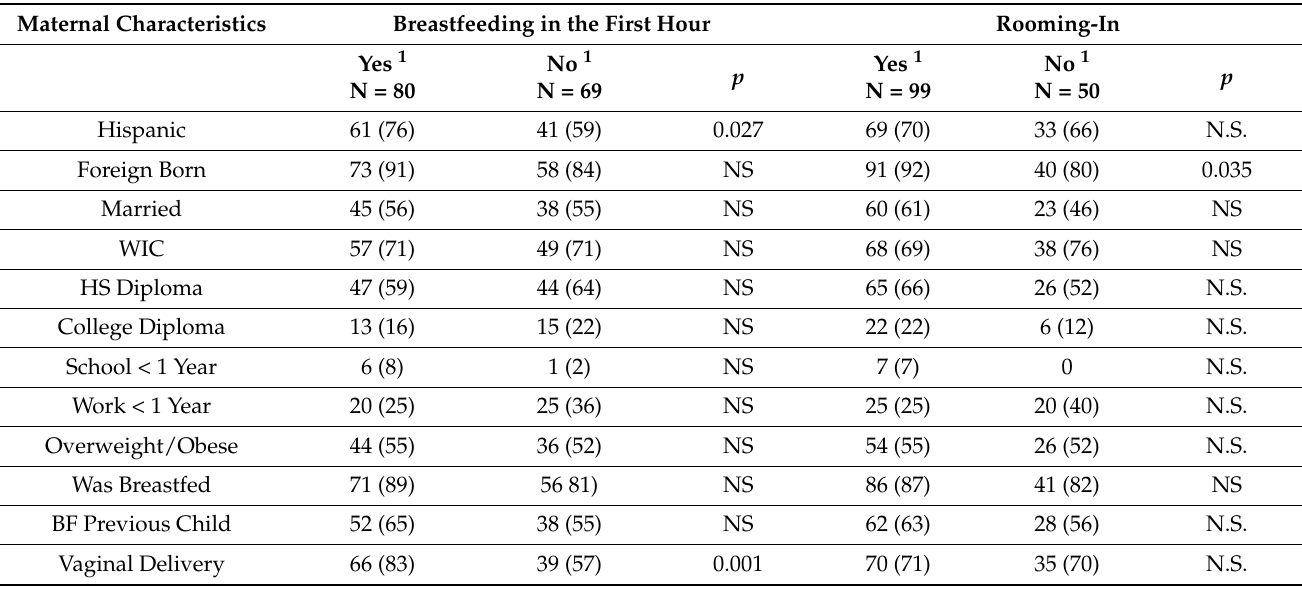
Table 1. Maternal Characteristics for Breastfeeding in the First Hour and Rooming-In.